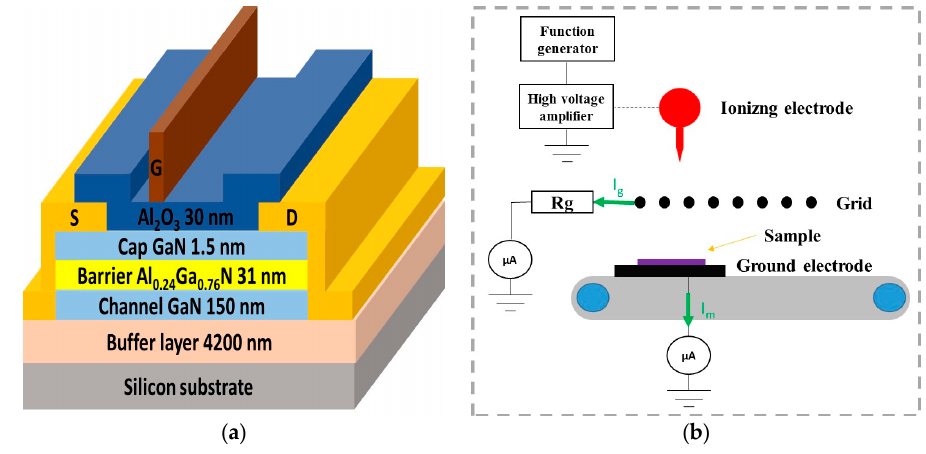
Figure 1. ( a ) Cross-sectional structure of the AlGaN/GaN metal-oxide semiconductor high-electron mobility transistor (MOS-HEMT) and ( b ) the corona-discharge plasma treatment system. D: drain; G: gate; S: source.